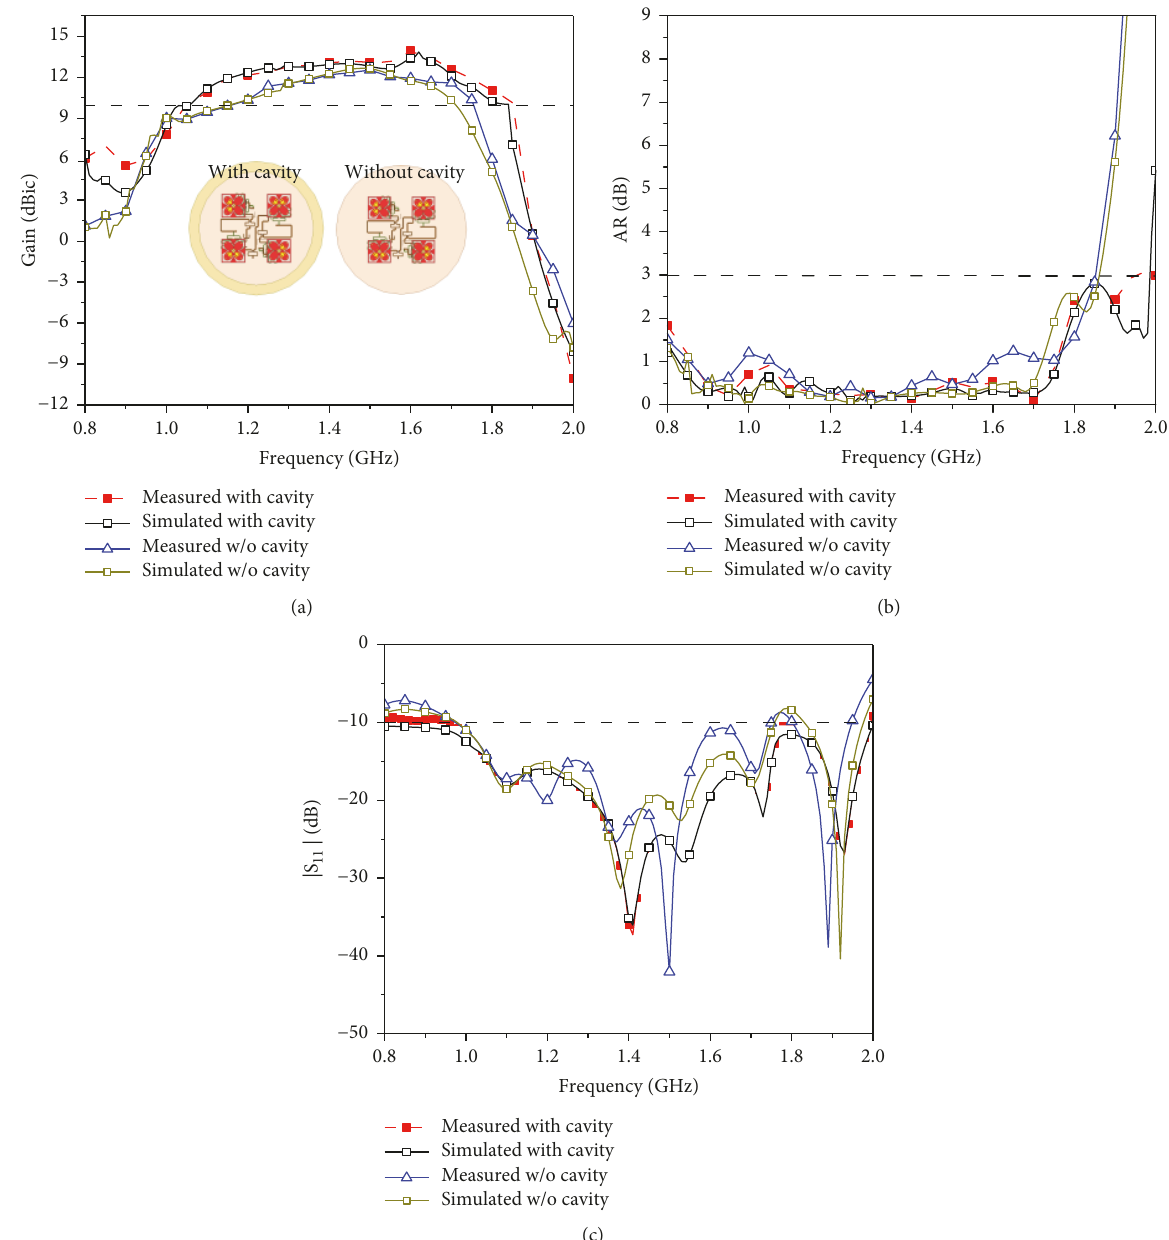
Figure 12: Measured and simulated gains, ARs at broadside direction, and S